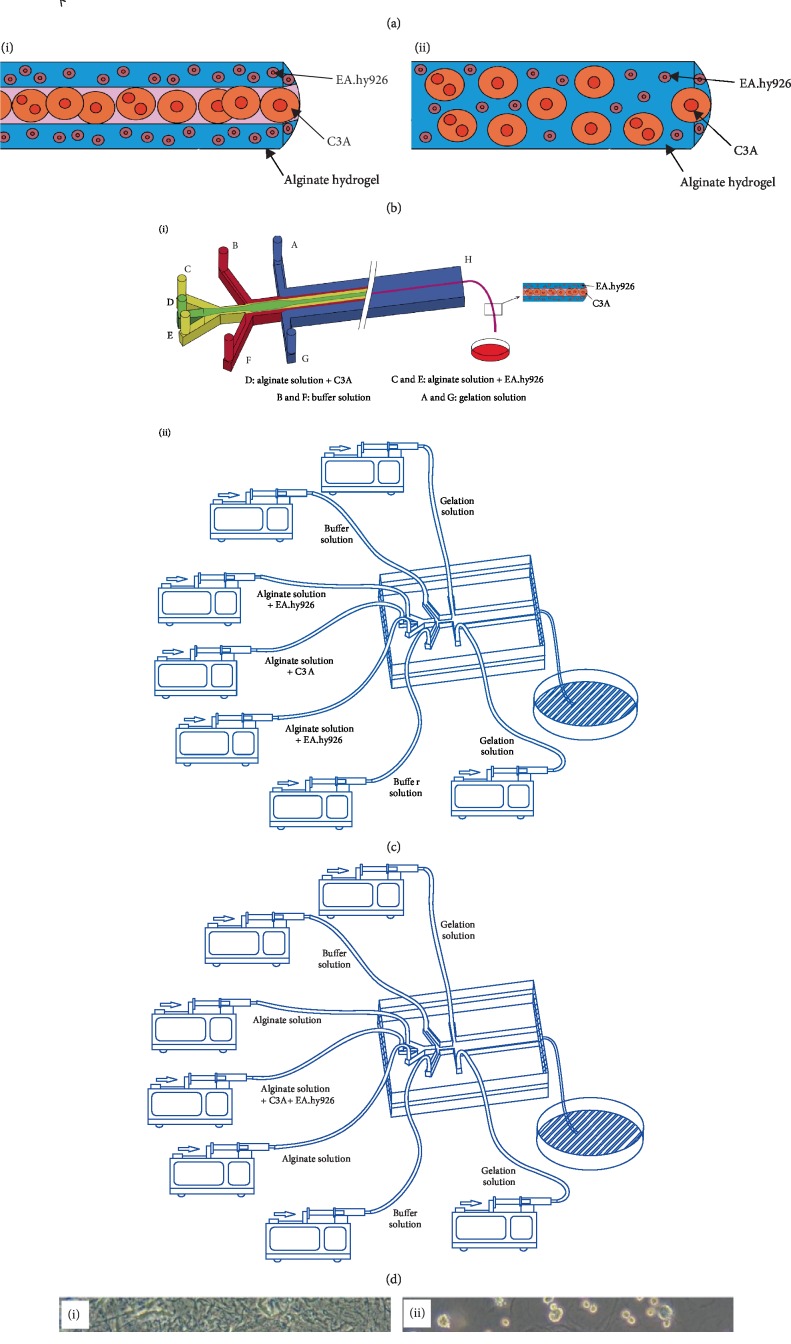
The overall experimental process. (a) Chip design and description: the main reaction channel of the chip measures 400 μm (W4) by 180 μm (D1) by 50 mm (L10). The inlet channels (A-G) are 1700 μm circular openings. The chip surface pores are connected to their respective inlet channels. The pore diameter φ is approximately 1200 μm. Other dimensions: L1 = 9967.12 μm, L2 = 8293.91 μm, L3 = 8467.12 μm, L4 = 328.87 μm, L5 = 8577.26 μm, L6 = 8532.61 μm, L7 = 300 μm, L8 = 8567.12 μm, L9 = 8467.12 μm, L11 = 70 mm, W2 = 100 μm, W3 = 200 μm, W5 = W6 = 12.3 mm, W7 = 25 mm, A1 = 30°, A2 = 60°, A3 = 90°, D2 = 2200 μm, D3 = 1000 μm, D4 = 3380 μm, and D5 = 2200 μm. (b) Three-dimensional culture formats used in this study: hepatic plate mimetic three-dimensional culture (i) and mixed three-dimensional culture (ii). (c) Hepatic plate-mimetic 3D coculture system schematic: laminar flow of the four solutions in the chip reaction channel (i) and overall experimental process (ii). (d) The mixed 3D coculture experimental process. (e) Images of the sandwich coculture method layers: bottom collagen coating (i), inoculated cells (ii), and upper collagen coating (iii) (all error bars: 100 μm).